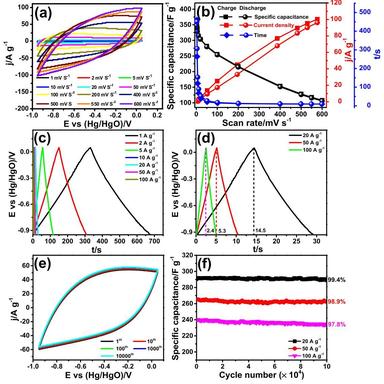
Electrochemical investigations of the as-prepared TWPC electrode: (a) CV curves at various scan rates from 2 to 600 mV s1 , (b) the obtained electrochemical parameters via CV measurement using various scan rates from 2 to 600 mV s1 , (c,d) GCD plots at different CDs from 1 to 100 A g1 , (e) long cyclic stability from CV test over 10,000 cycles at an ultra-high scan rate of 200 mV s1 and (f) the specific capacitance holding over 130,000 cycles of GCD test at ultra-high CDs of 20, 50 and 100 A g1 .